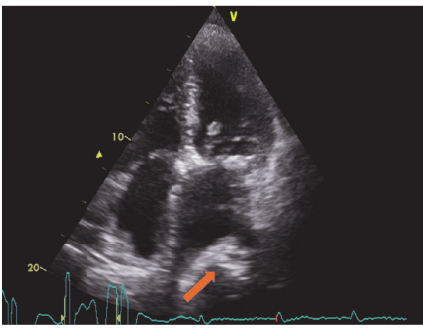
Figure 1: Echocardiography (four-chamber view) of the heart depicting a mass compressing the left atrium.